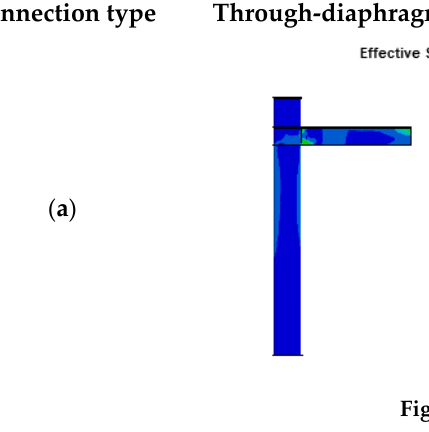
Figure 11. Normalized moment-drift curves generated by two different finite element codes for the proposed column.